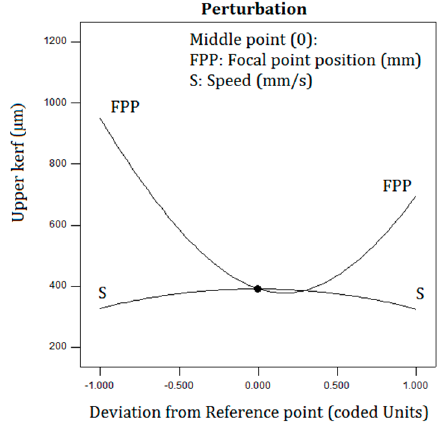
Figure 7. The top kerf width perturbation plot.